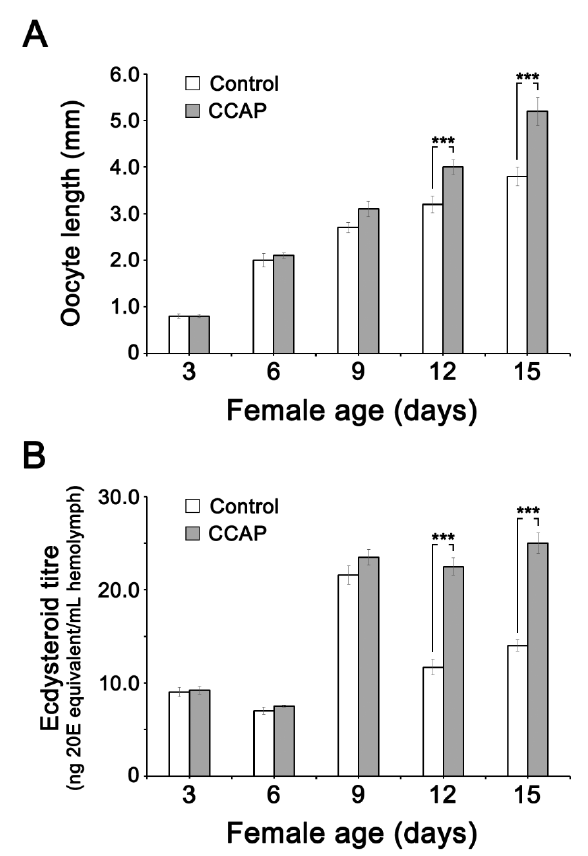
Figure 3. E ff ect of CCAP injection on oocyte growth and 20E titers in hemolymph. ( A ) E ff ect of Figure 3. Effect of CCAP injection on oocyte growth and 20E titers in hemolymph. ( A ) Effect of CCAP